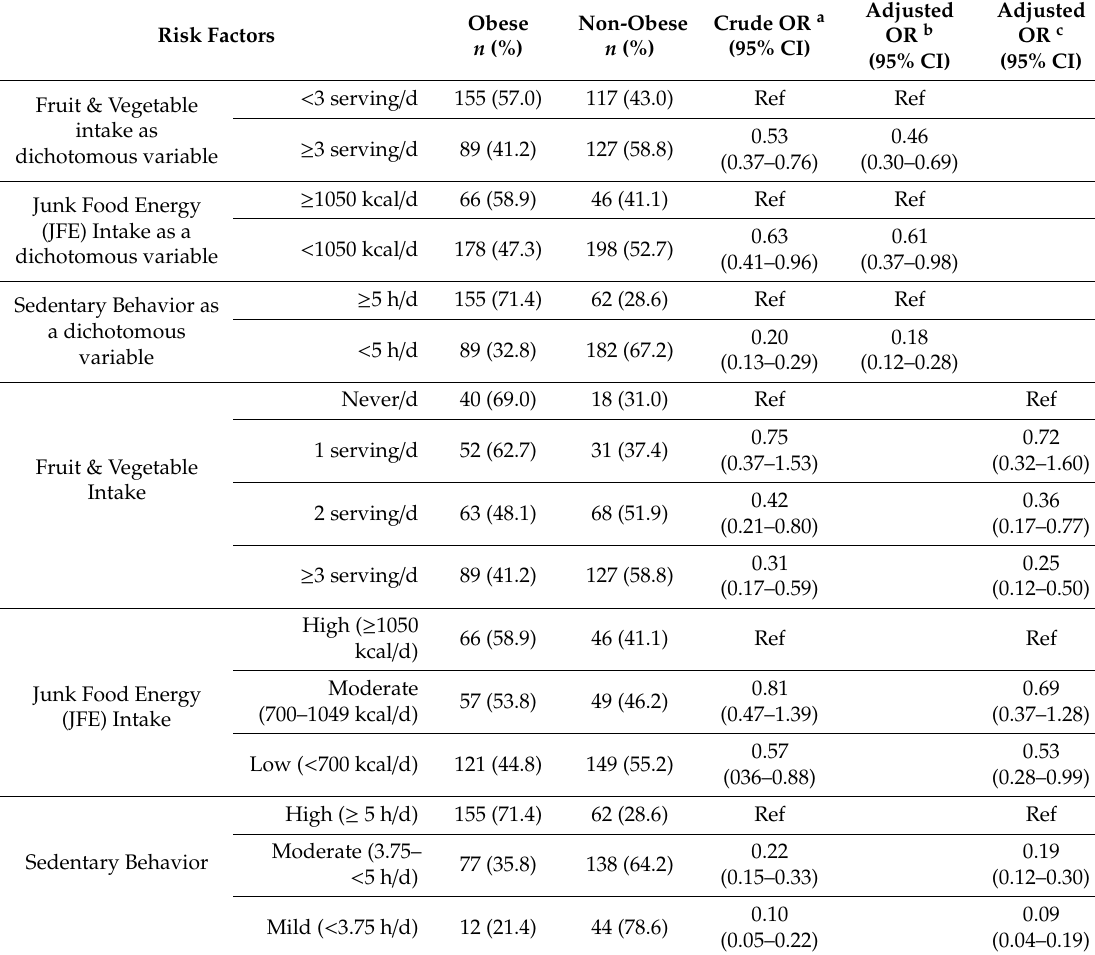
Table 2. Fruits & vegetables consumption, junk food energy intake, and sedentary behavior as risk factors of childhood